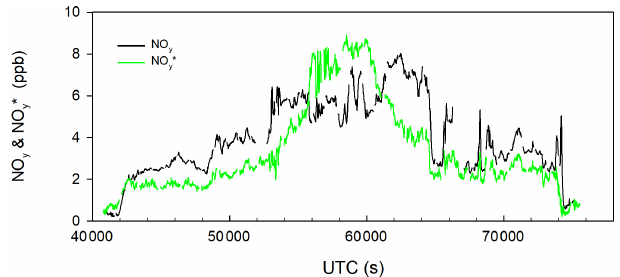
Figure 4. PGS flight 14 on 26 February 2016. NO y (observed) and NO ∗ y